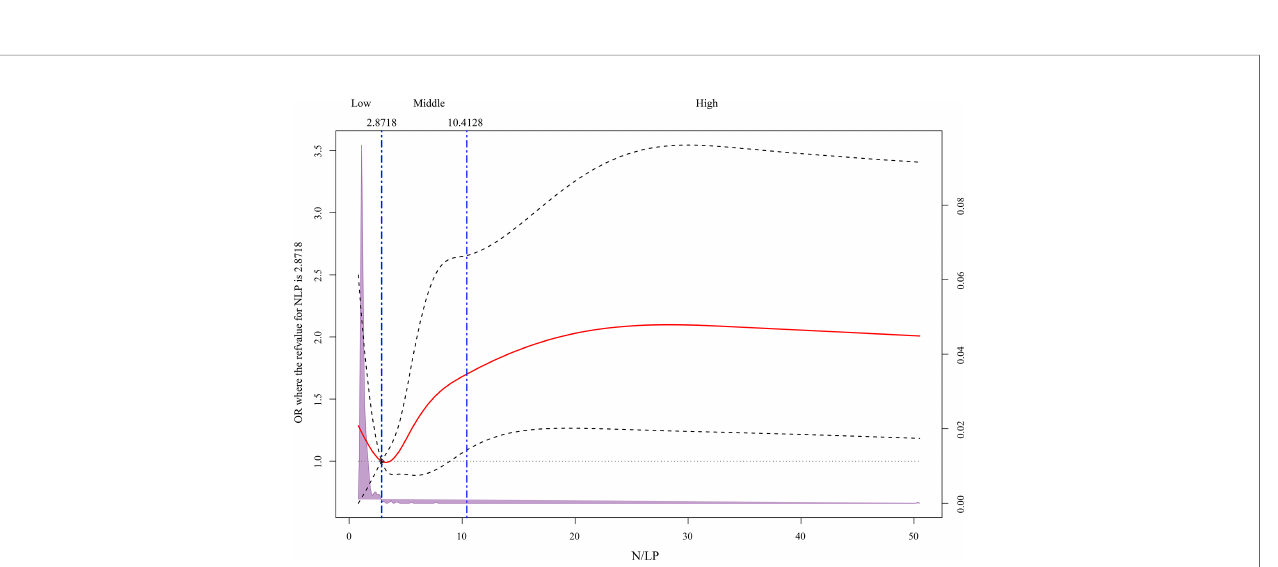
FIGURE 5 | Multivariable adjusted odds ratios for severe acute kidney injury (AKI) occurrence according to initial N/LP on a continuous scale. Solid red lines were multivariable-adjusted odds ratios, with dashed bold lines showing 95% con fi dence intervals derived from restricted cubic spline regressions with fi ve knots. Reference lines for no association were indicated by the black dashed lines at a hazard ratio of 1.0 and the reference knot setted at 2.8718. Purple regions indicated the fraction of the population with different levels of N/LP. All 16 covariates were adjusted. AKI and corresponding stage were diagnosed based on serum creatinine and urine output